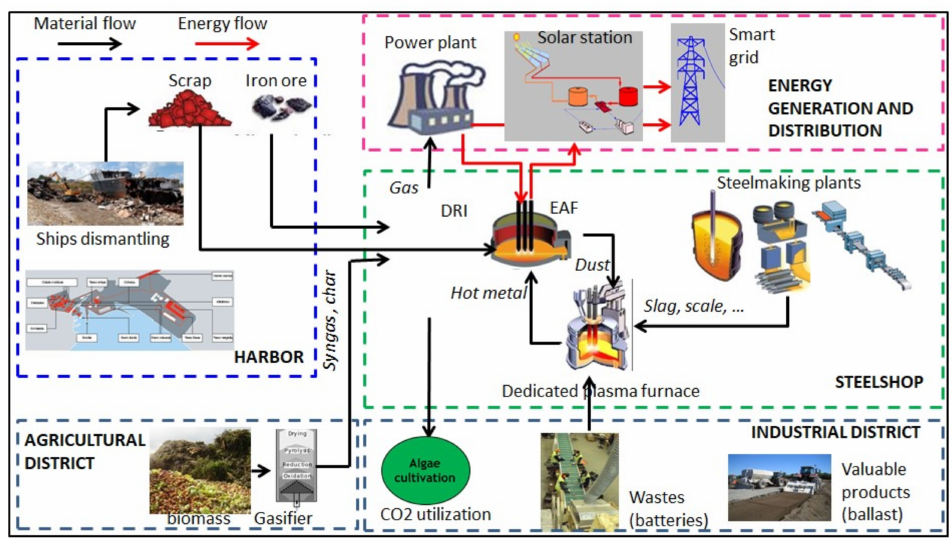
Figure 3. Conceptual design of steel industry-based industrial